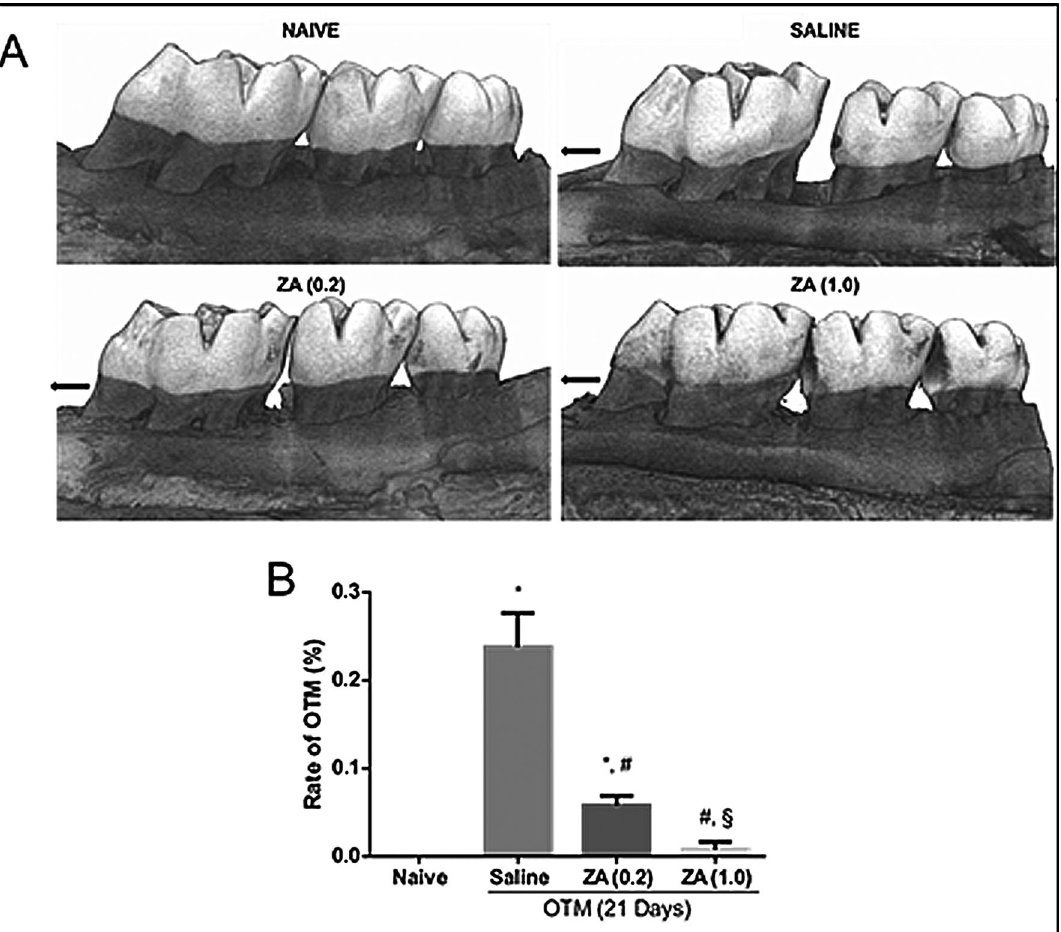
Figure 3. Effect of zoledronic acid on OTM with 21 days of tooth displacement in the experimental groups. (A) Macroscopic analysis by computed microtomography. The black arrow indicates the direction of the force on the compression side. (B) Bars represent mean ± SEM of 6 animals per group. (*) indicates difference when compared to the naive group (#) indicates difference when compared to the saline group. (§) indicates difference when compared to the ZA group (0.2) (ANOVA p < 0.001, Levene p = 0.001 and Games—Howell pos-hoc